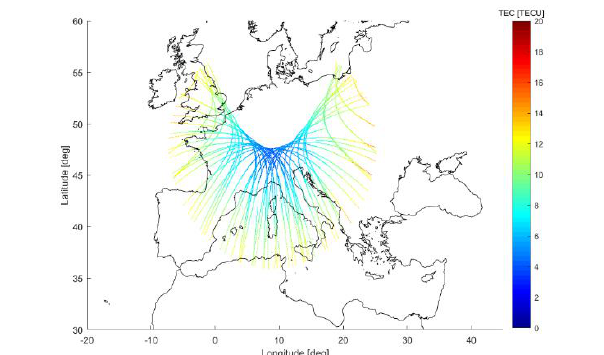
Figure 15. Ionospheric pierce points with line of sight RMS value calculated from the EGNOS VTEC map. The simulated site is in Zürich on